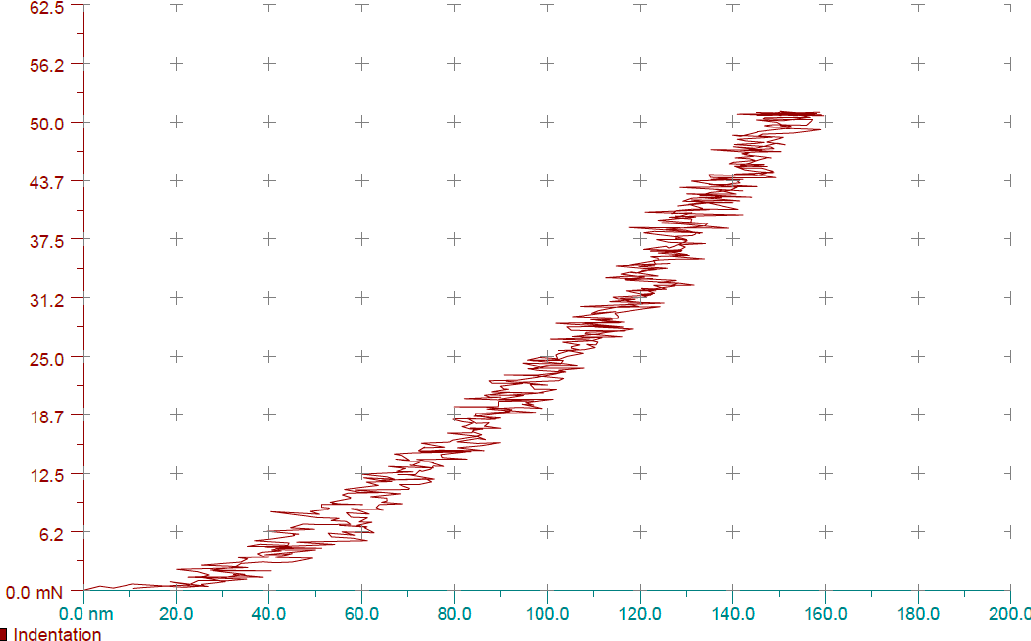
Figure 10. Loading–unloading curve.